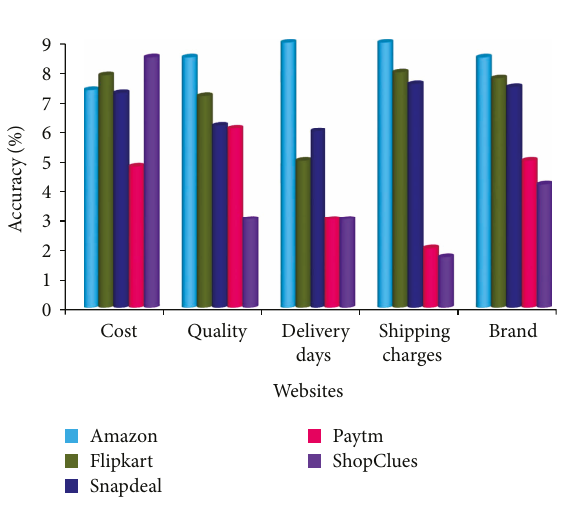
Figure 4: Comparative analysis.